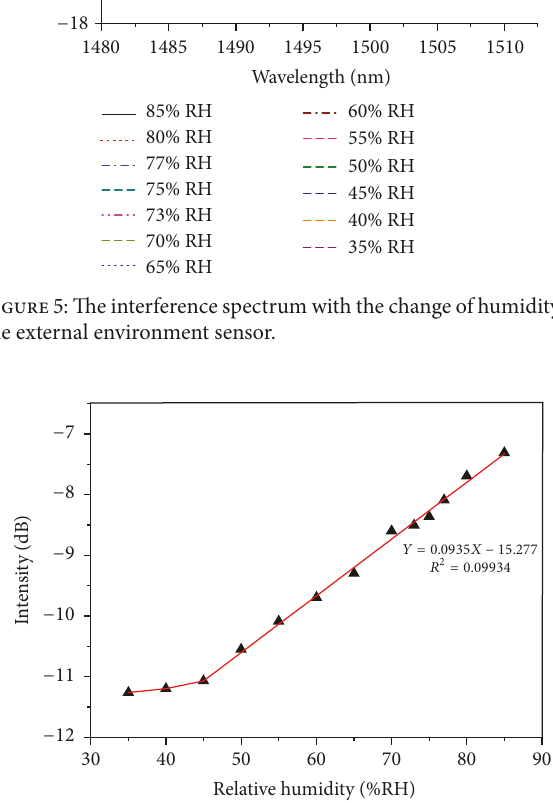
Figure 6: The relationship between the intensity change and humidity.